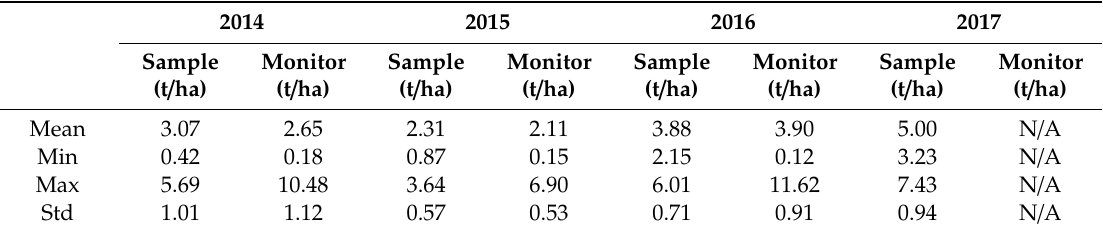
Table 3. Comparison between yield (t / ha) sampled and monitoring data (mean, max, min and